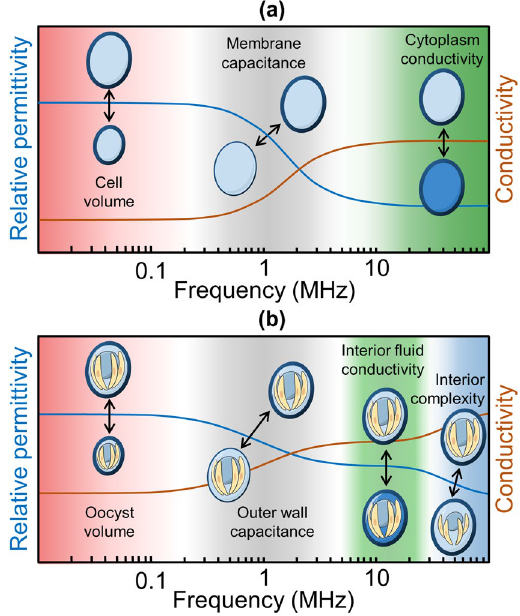
Figure 2. Illustration of the frequency-dependent dielectric response of a single-shelled particle or a C. parvum oocyst. ( a ) A simplified, single shell model is often used to approximate the dielectric properties of cells/ particles. A cell/particle which is surrounded by a shell (membrane) experiences a single dielectric dispersion, within the frequency range of 1–10 MHz (called the β -relaxation). ( b ) For more complex biological structures, like the C. parvum oocyst, a simplified single-shell model cannot accurately calculate the dielectric properties of the oocyst components. For example, C. parvum oocysts are likely to experience multiple relaxations due to the polarisation of successive shells as the frequency increases. Note that the frequency window for these relaxations depends on the conductivity of the suspending